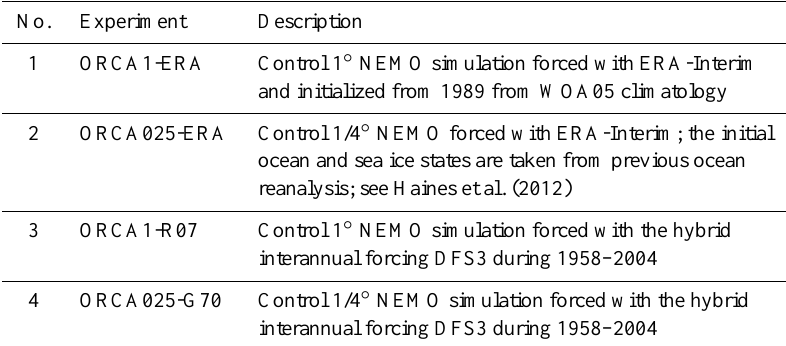
Table 1. Definition of the experiments used in this paper. No.